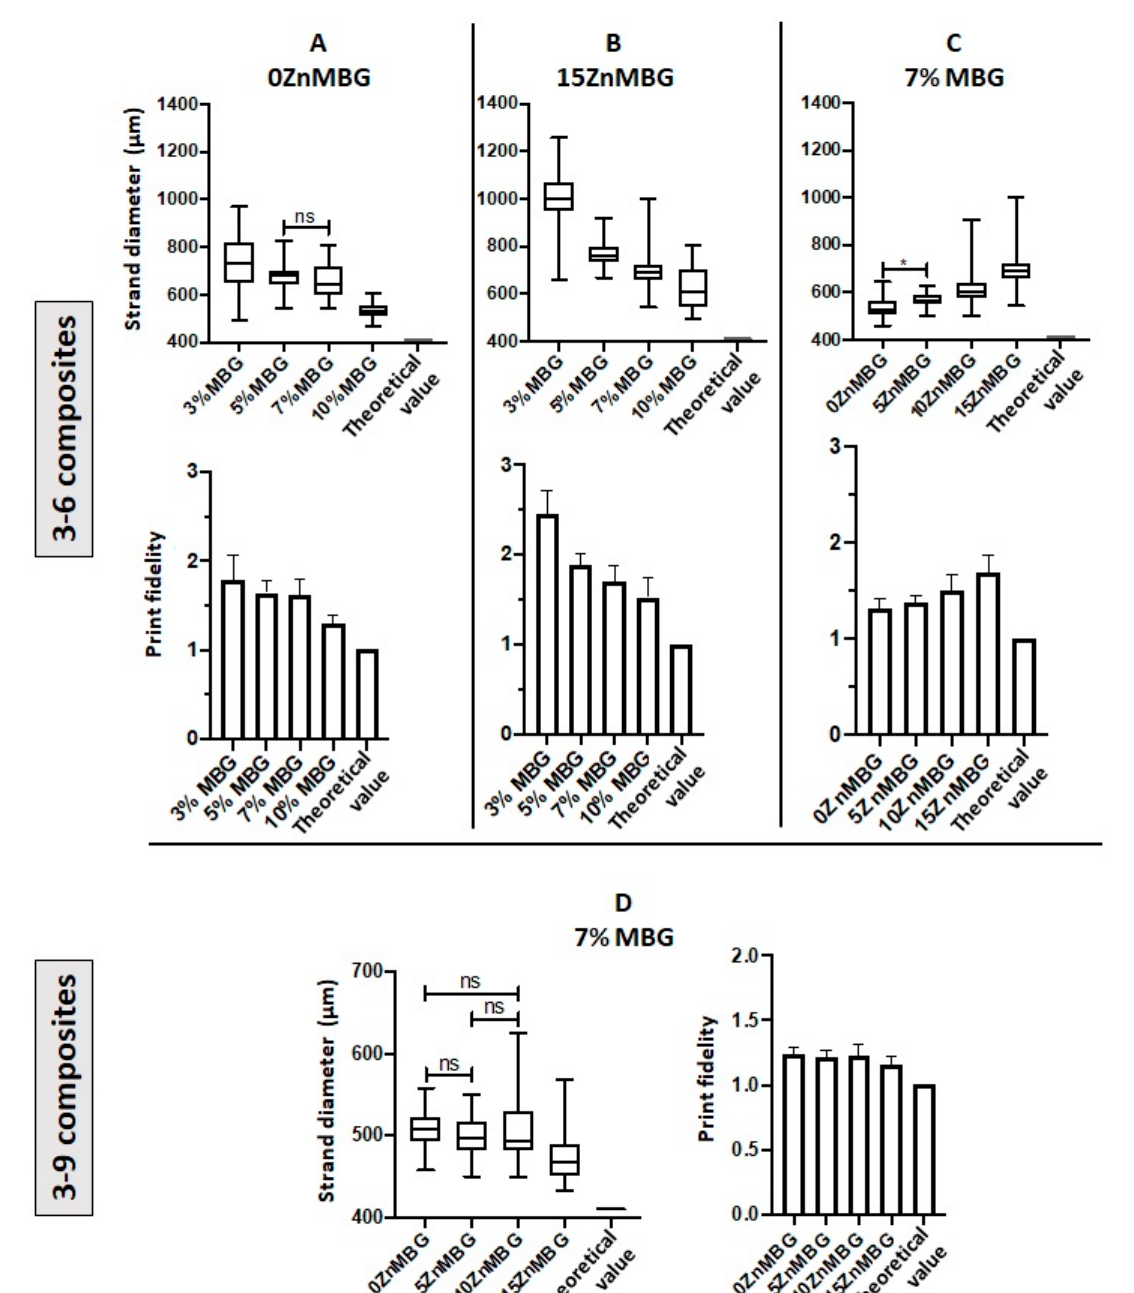
Figure 5. Strand diameters and print fidelities of 3–6 and 3–9 composite scaffolds. ( A ) Strand diameters (upper) and print fidelity (lower graph) of scaffolds printed with 3–6 composites containing different amounts of basic MBG without incorporated Zn (15% Ca). ( B ) Strand diameters (upper) and print fidelity (lower graph) of scaffolds printed with 3– 6 composites containing different amounts of 15ZnMBG (0% Ca). ( C ) Strand diameters (upper) and print fidelity (lower graph) of scaffolds printed with 3–6 composites containing 7% of each ZnMBG. ( D ) Strand diameters (left) and print fidelity (right) of scaffolds printed with 3–9 composites containing 7% of each ZnMBG. Value 1 in the shape fidelity charts corresponds to the inner diameter of the extrusion nozzle of 410 µ m (theoretical optimum). All strand diameters are significantly different from the theoretical optimum within each graph with p < 0.0001, except for *, which has p < 0.05, and “ns”, which are not significant; Values are means ± SD, n = 3.